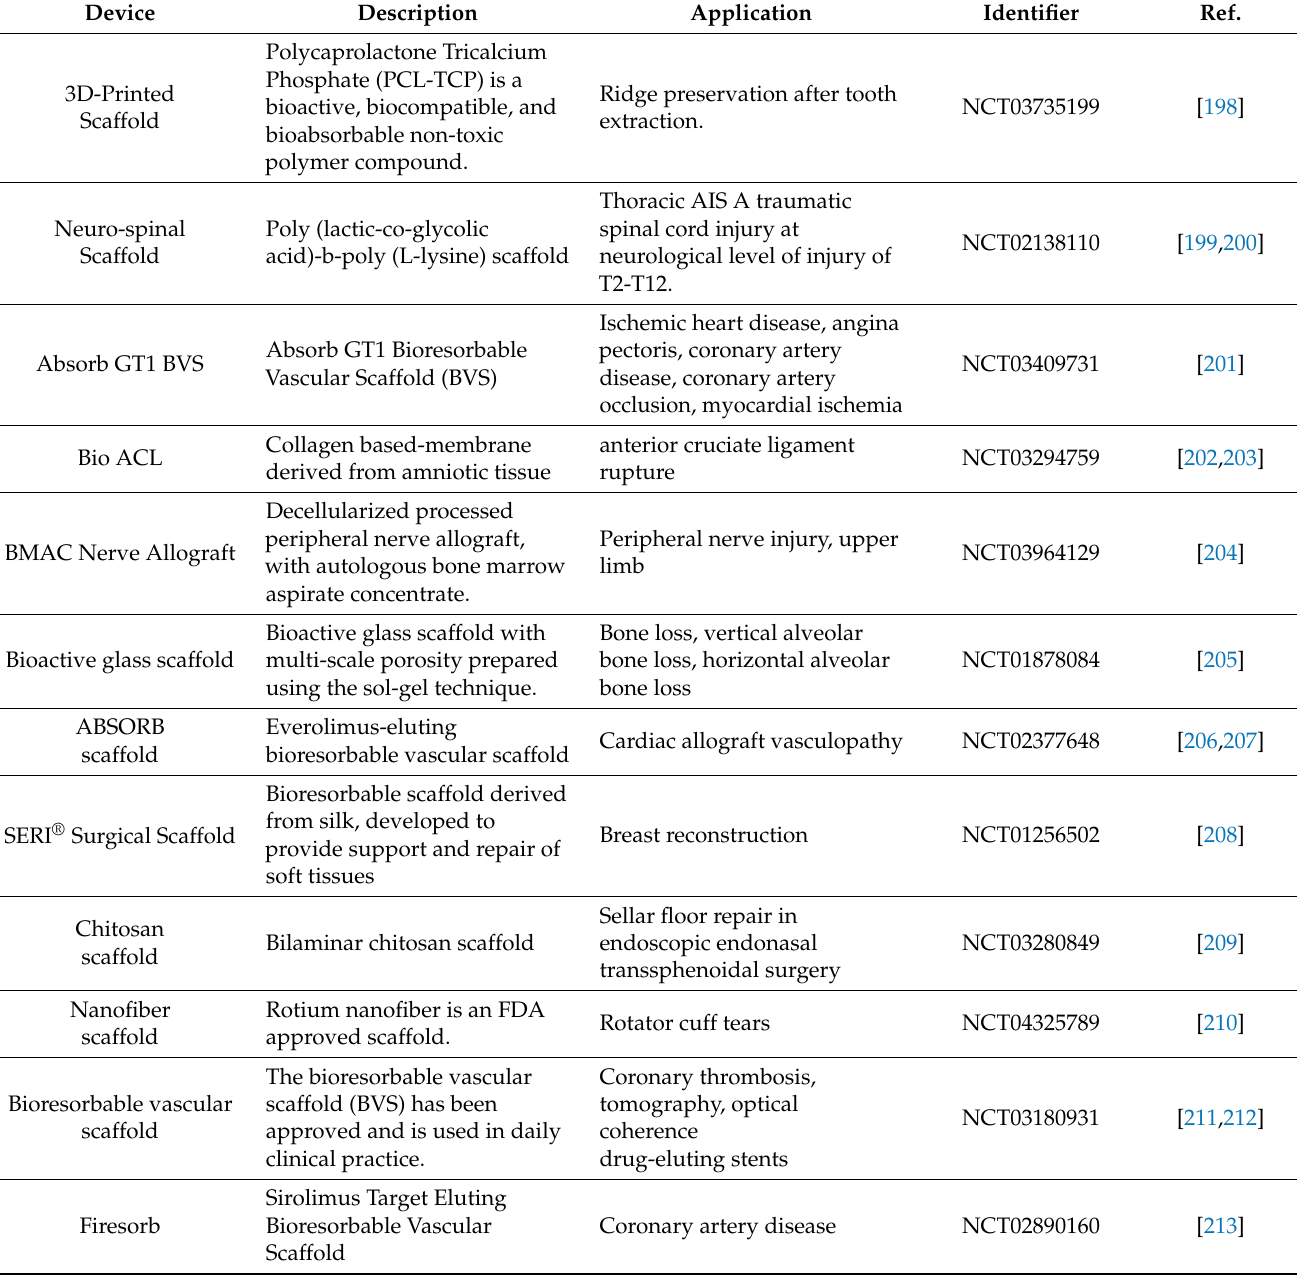
Table 4. Different polymer-based medical devices approved to use in clinical